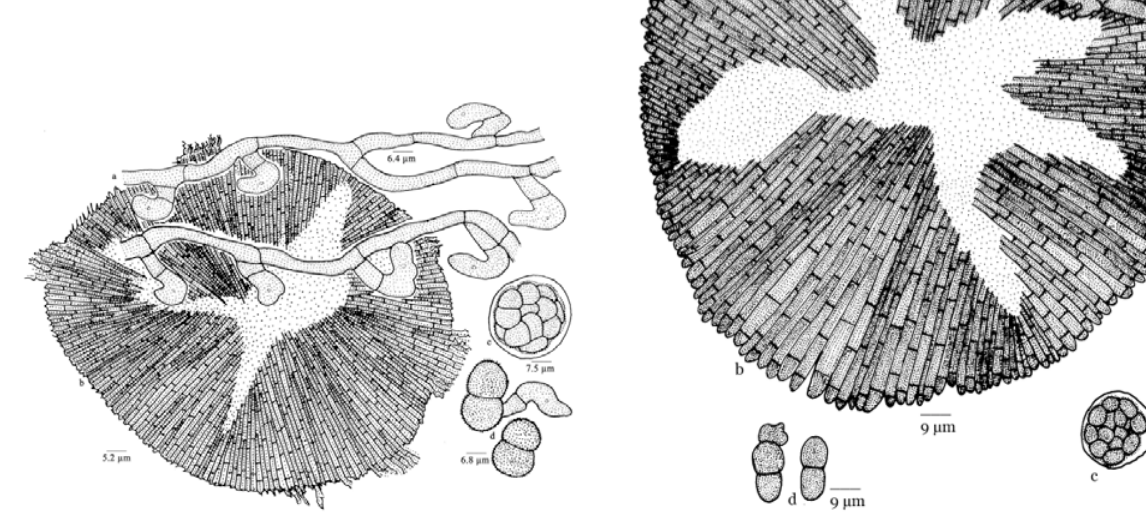
Figure 166. Asterina tertia a - Appressorium, b - Thyriothecium, c - Ascus, d -